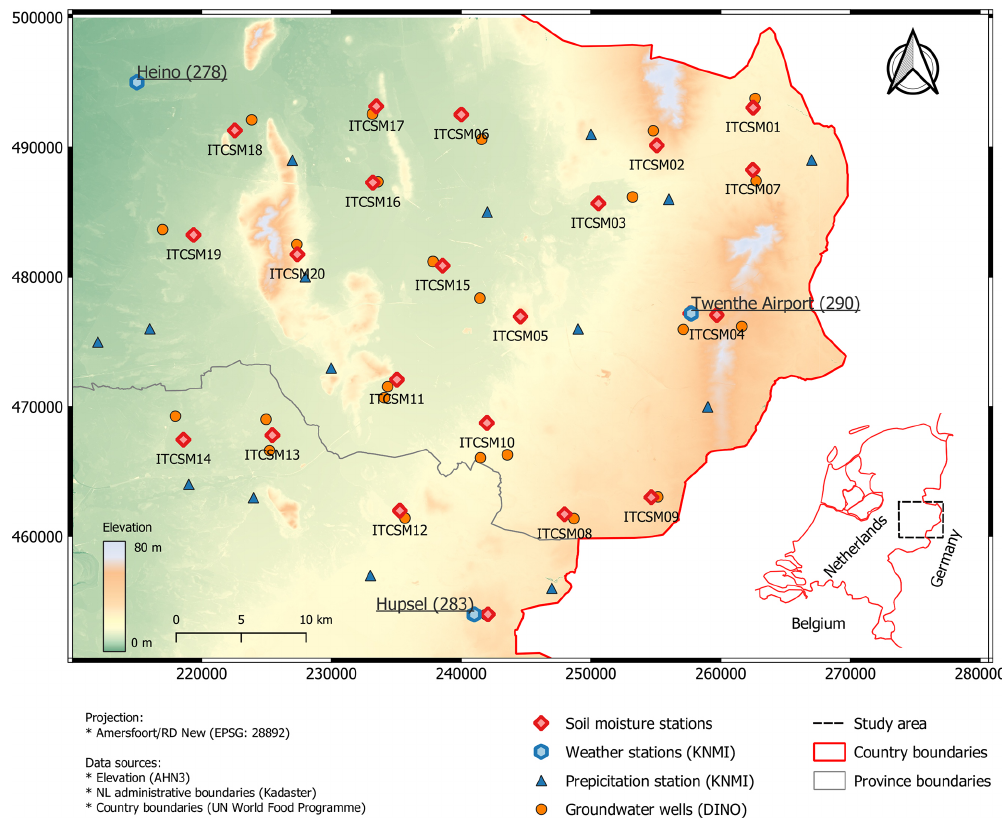
Figure 1. The topography of the study area (source: 5m spatial resolution AHN3; AHN, 2019) and the locations of the soil moisture/temper- ature monitoring stations, KNMI automated weather stations (underlined with ID in parenthesis), KNMI precipitation stations, and ground- water monitoring wells available in DINOLoket.